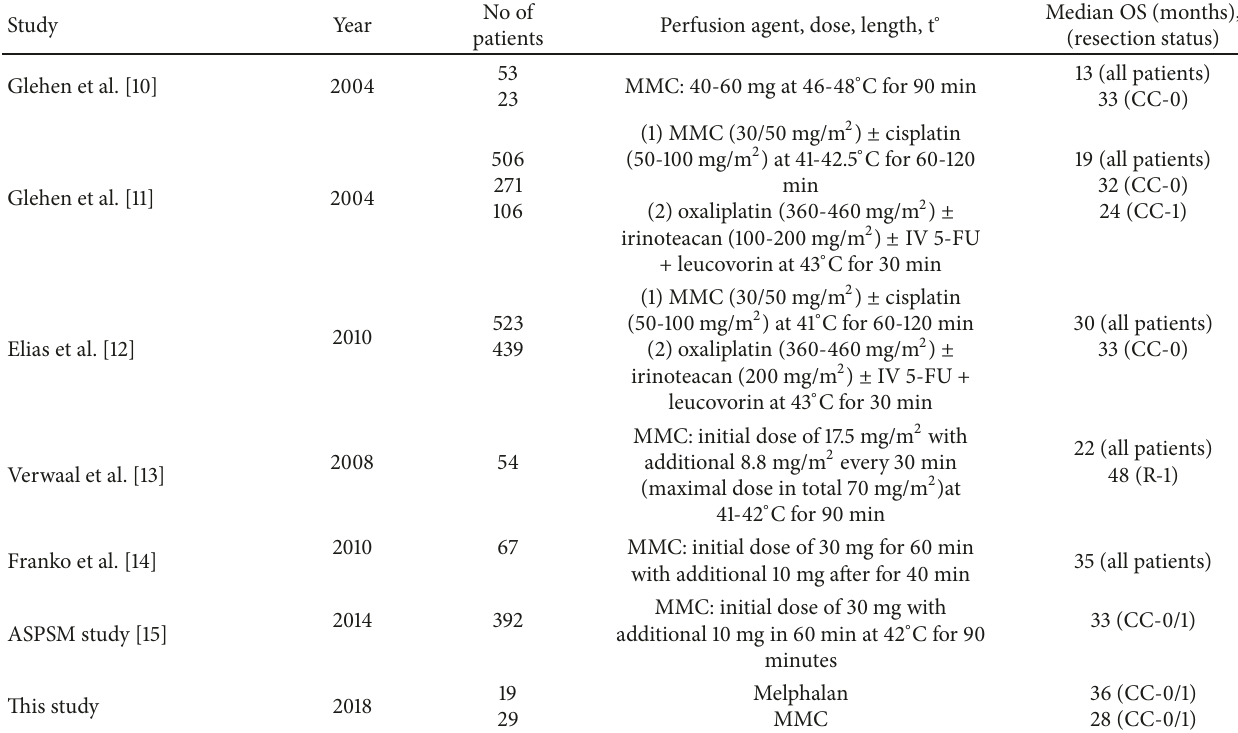
No of Perfusion agent, dose, length, t ∘ patients